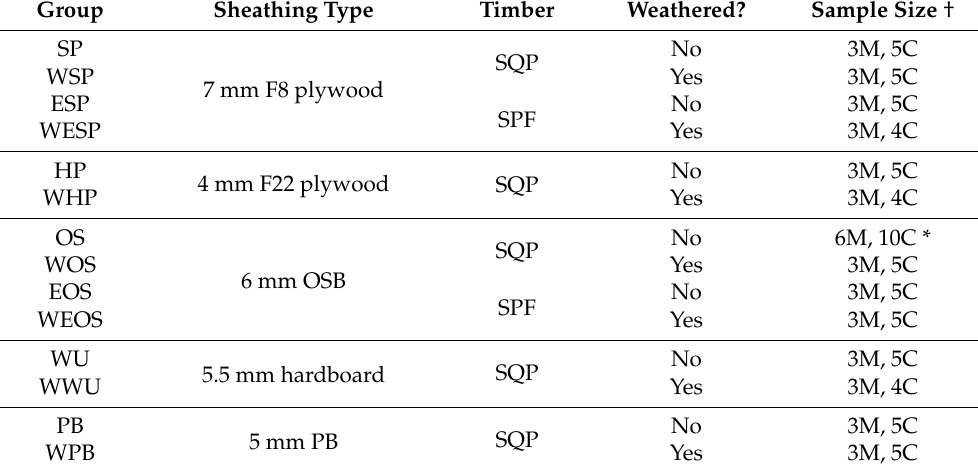
Table 1. Test matrix.